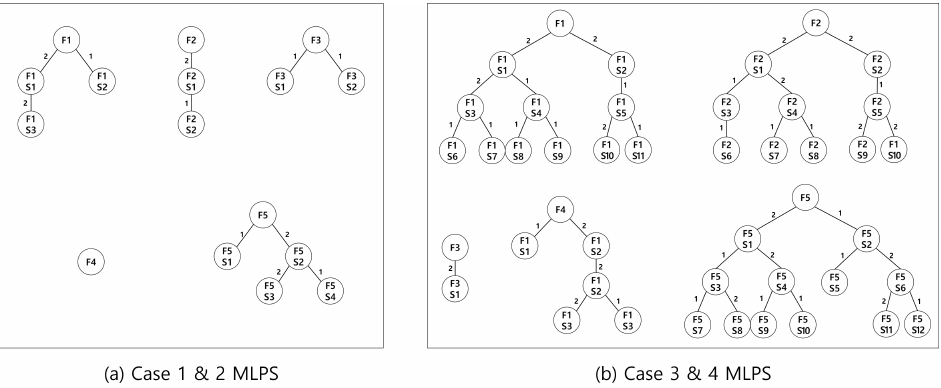
Figure 6. Product structure used in numerical experiment. ( a ) The MLPS of Case 1 & 2; ( b ) The MLPS of Case 3 &